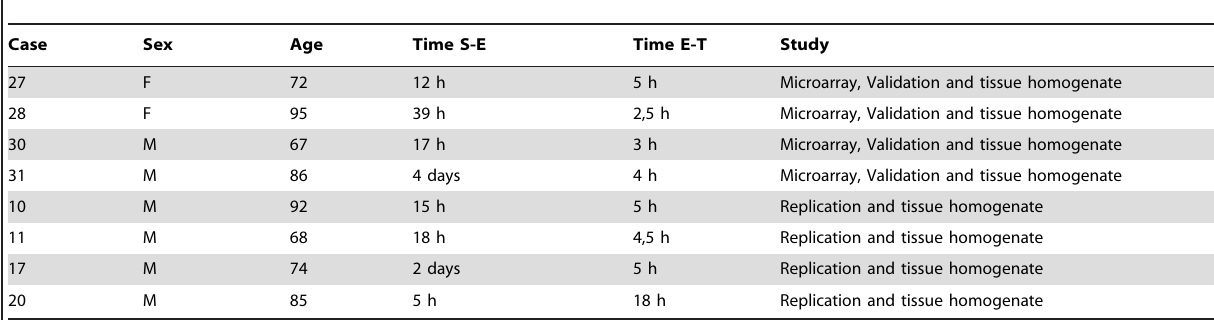
Table 1. Demographic and tissue sampling